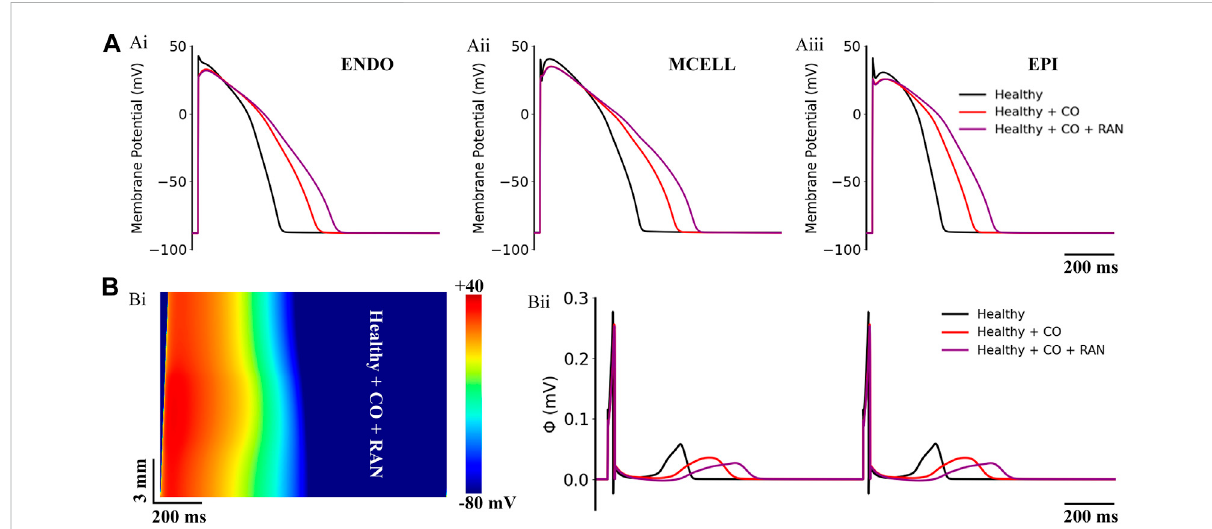
FIGURE 4 Actions of ranolazine (RAN) on CO-affected myocardial cells and tissues. (A) The comparison of action potentials of three cell types under ‘ healthy ’ , ‘ healthy + CO ’ , and ‘ healthy + CO + RAN ’ conditions. (B) Spatial-temporal plots under the ‘ healthy + CO + RAN ’ condition (Bi), and the corresponding pseudo-ECG (Bii).